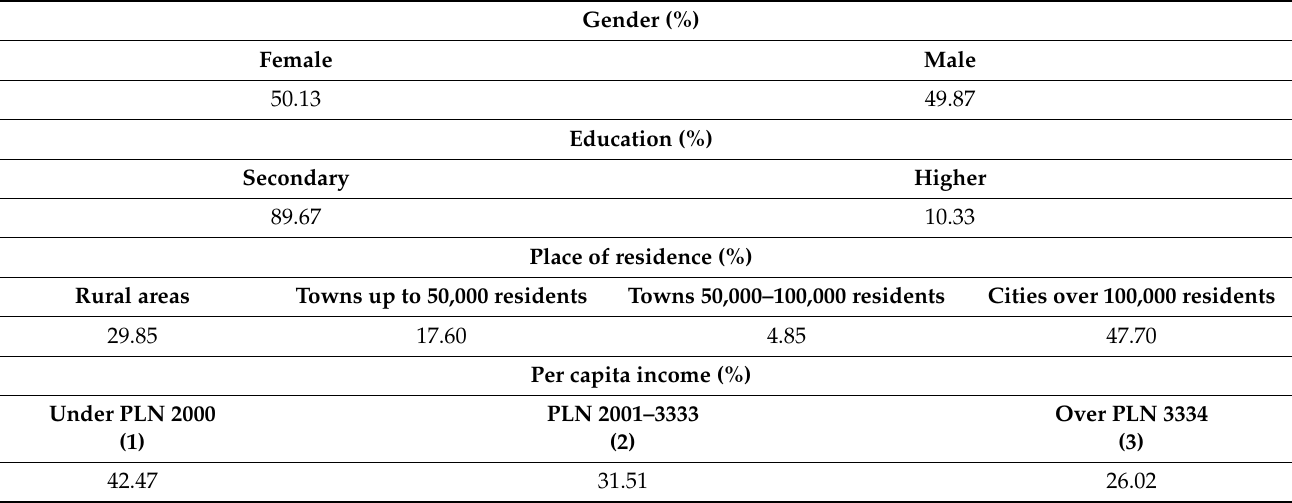
Table 2. Socio-demographic structure of the research group accounting for selected characteristics.